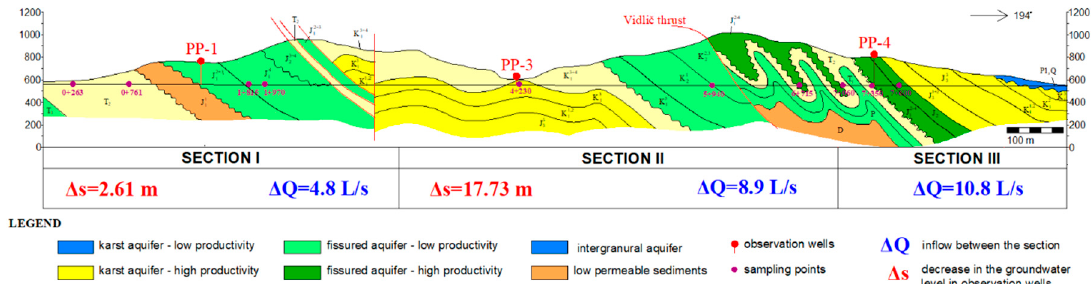
Figure 6. Hydrogeological section along the tunnel with groundwater sampling points (including groundwater inflow rates and comparative decreases in groundwater levels at the observation wells, relative to the tunnel sections).